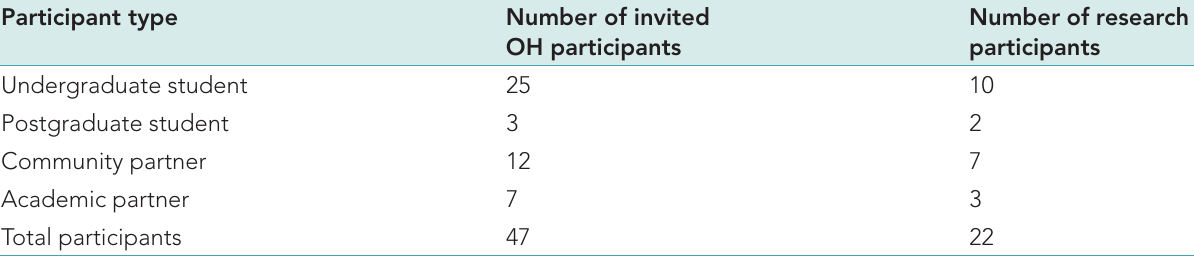
Table 1: Characteristics of Our Health participants and research participants (Source: Authors, 2022) Participant